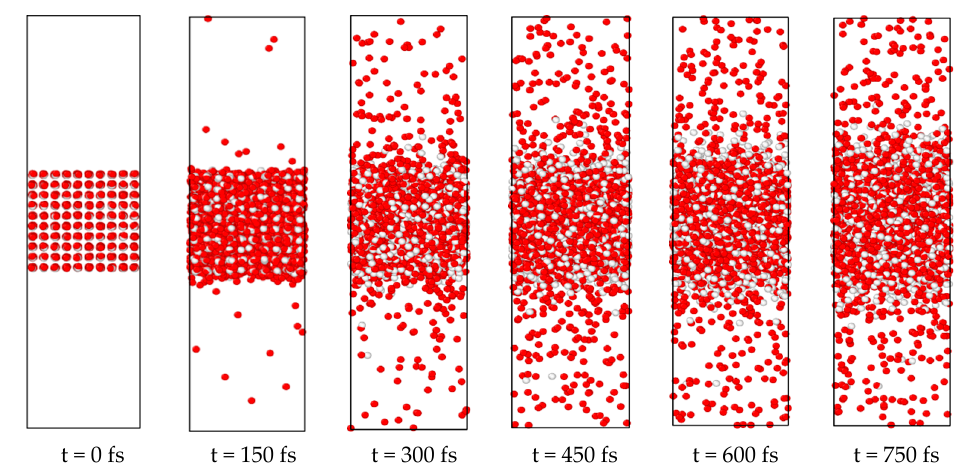
Figure 3. Homogenous boiling of water at 400 K temperature.